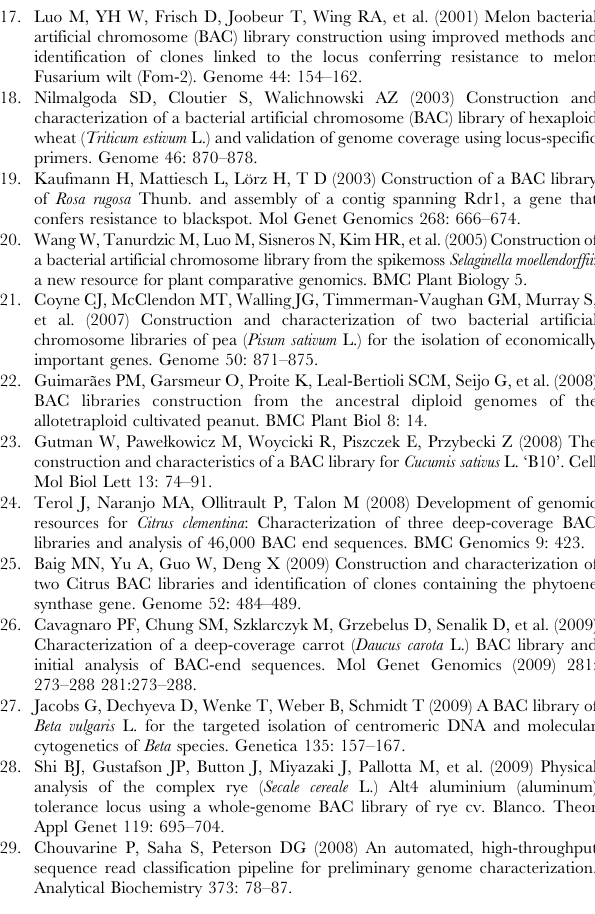
Figure S1 Comparison of LBAC, the consensus sequenc- es of the two major EST variants discovered through BLAST alignment (i.e., CSV1 and CSV2), and the P . halepensis LEA EST sequence (PHLE). For each sequence, the start codon is highlighted in light blue, the stop codon in pink, and the intron (if any) in light orange. The exons in CSV1 are identical to those in the LBAC gene. 2.5% of the ESTs used to create CSV1 contained a putative intron with 100% sequence identity to the intron in LBAC (light orange highlight). CSV2 was derived from 11 sequences that showed significant and consistent differences from CSV1/LBAC. The region believed to represent an intron in CSV1/LBAC was present in all transcripts used in generating CSV2, and indeed it may be that all mature sequences produced from this locus/allele contain the ‘‘intronic’’ region (hence this region is not highlighted as an intron in CSV2). Compared to CSV1, CSV2 contains a deletion in the putative intron region (bases 225-236), which may account for improper splicing of the CSV2 transcript, and a 13 nt insertion immediately after the stop codon (bases 455-467). The 13 nt insertion is also observed in PHLE. Single nucleotide differences between a particular sequence and the LBAC sequence are highlighted in yellow.